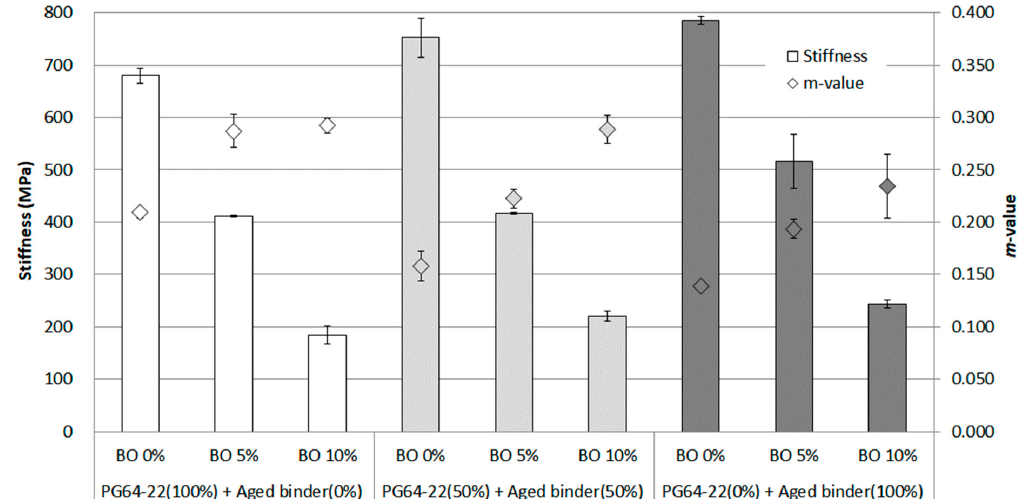
Figure 10. Stiffness and m -value of each asphalt binder containing the base oil for RTFO + PAV condition at − 24 °C.